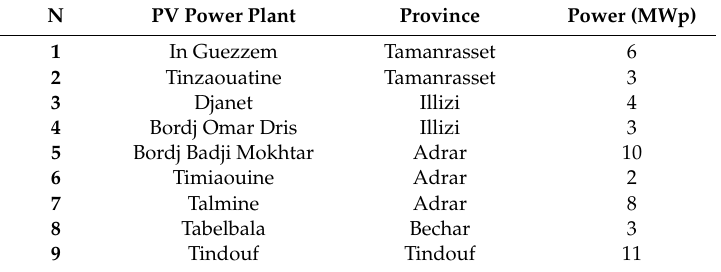
Table 3. Projects of Photovoltaic power plant installation in